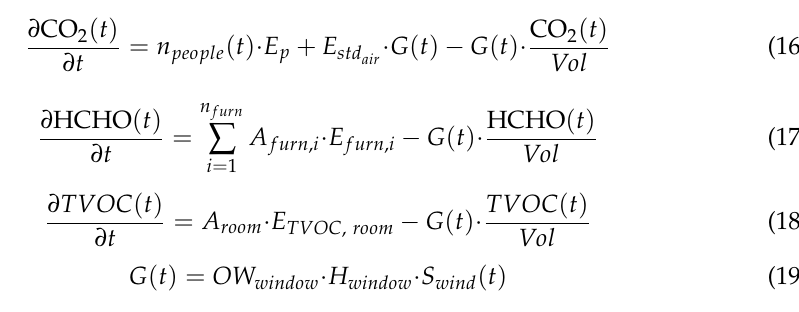
Table 7. IAQ model parameters (Equations